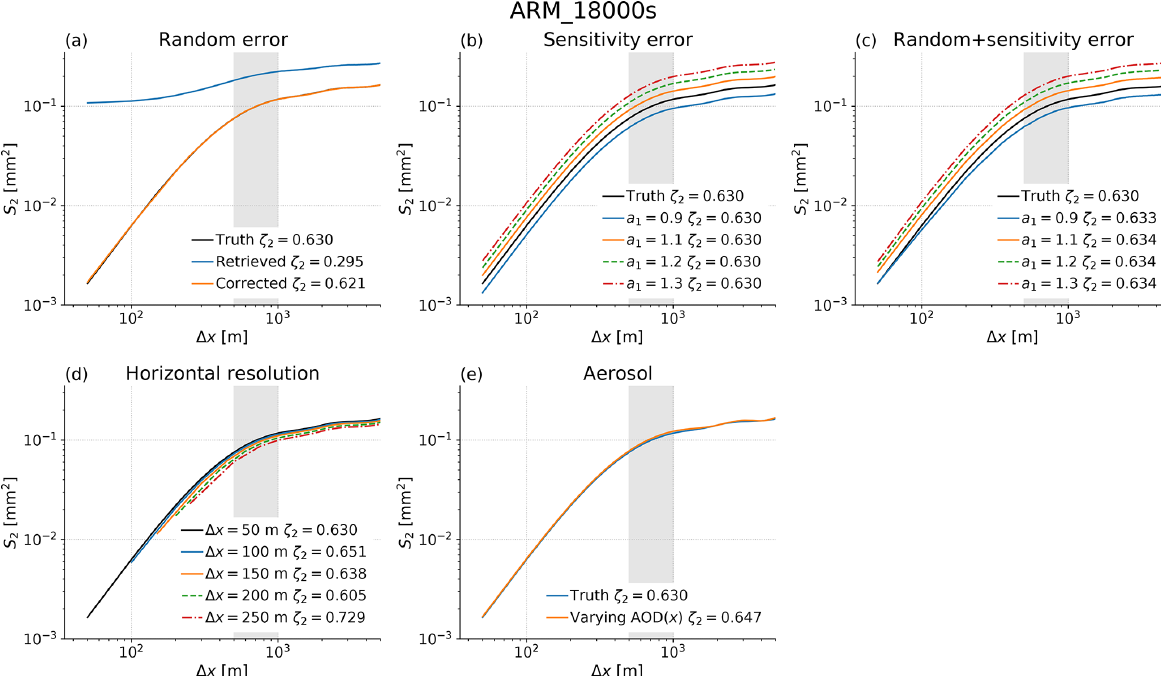
Figure 5. Sensitivity of derived S 2 to retrieval errors and spatial resolution; the legends in each case report the calculated exponent from a fit over separations 0.5–1km, the region which is shaded grey in each panel. In each case “truth” refers to the value calculated from TCWV at a native LES resolution of 50m. (a) Blue shows S 2 derived from retrieved TCWV including random error only, and orange the S 2 after subtracting the estimated retrieval variance. (b) S 2 calculated with no random error but non-unity sensitivity dTCWV ret / dTCWV eff as defined by the a 1 trend parameter in Eq. (8). (c) The result when combining random error and sensitivity error, after subtraction of the random error estimated from each retrieved field. (d) S 2 calculated after smoothing the field resolution sequentially to 250m × 250m. (e) S 2 calculated for a horizontally varying aerosol field where TCWV ret changes sinusoidally by 0.3% every 1km, representing a change of 0.3 in AOD based on the TCWV ret response from Fig.